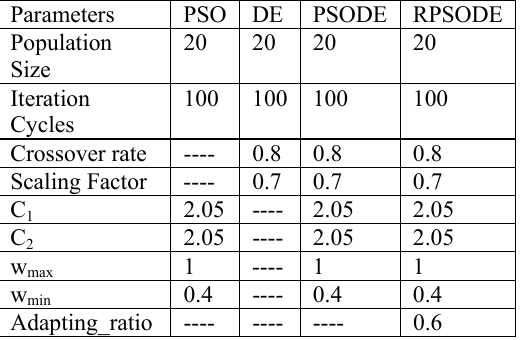
Table1. PSO, DE, PSODE and RPSODE Parameters